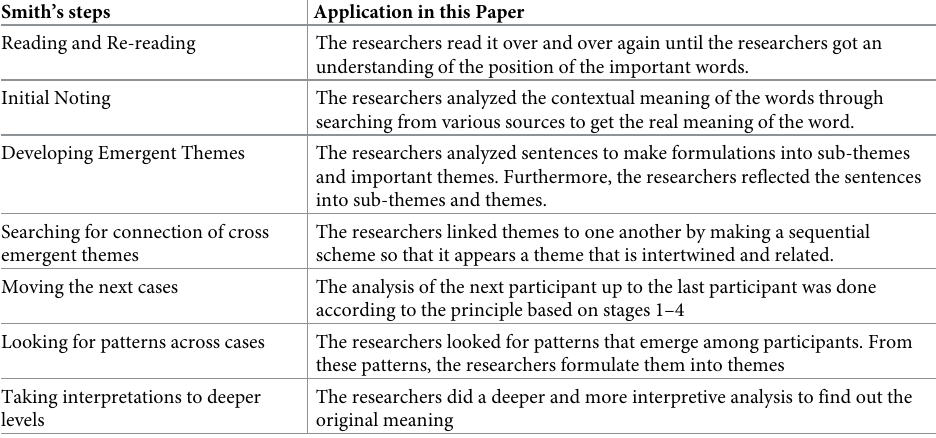
Table 1. Phenomenological Analytic